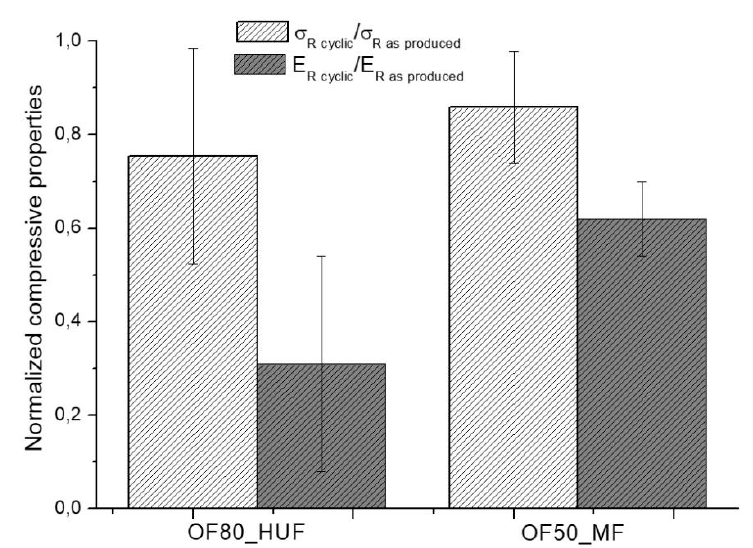
Figure 4. Normalized compressive tests after repeated heating-cooling cycles on OF80_HUF and OF50_MF samples.